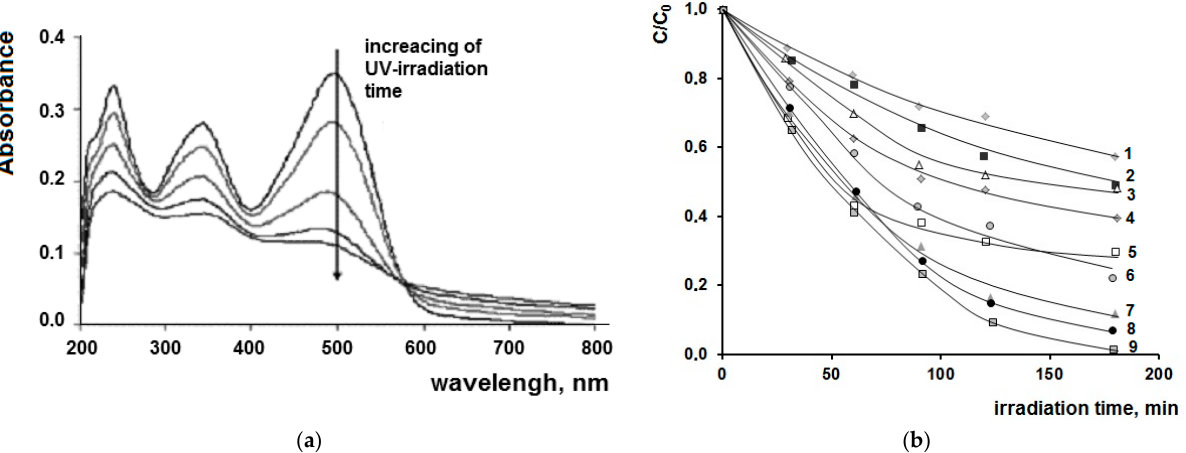
Figure 5. ( a ) Typical change in the spectrum of aqueous CR solution under UV irradiation in the